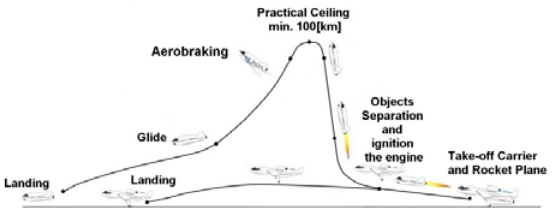
Fig. 2. The MAS mission